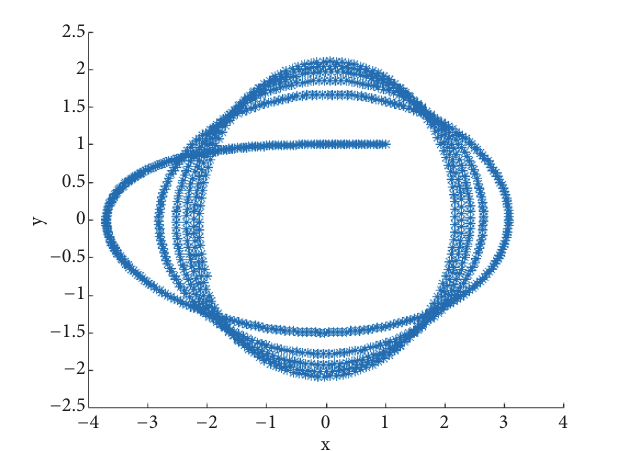
Figure 12: Convergence graph of